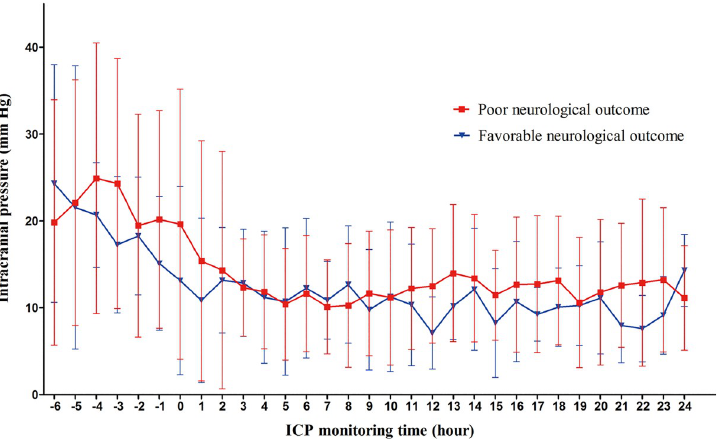
Fig 2. ICP patterns in 20 patients with established RICH before BCT, and monitored from 6 h before BCT. Four patients had favorable neurological outcome while 16 patients had poor neurological outcome. The ICP curves show the means ± standard deviation at each monitoring time. ICP, intracranial pressure; RICH, refractory intracranial hypertension; BCT, barbiturate coma therapy.